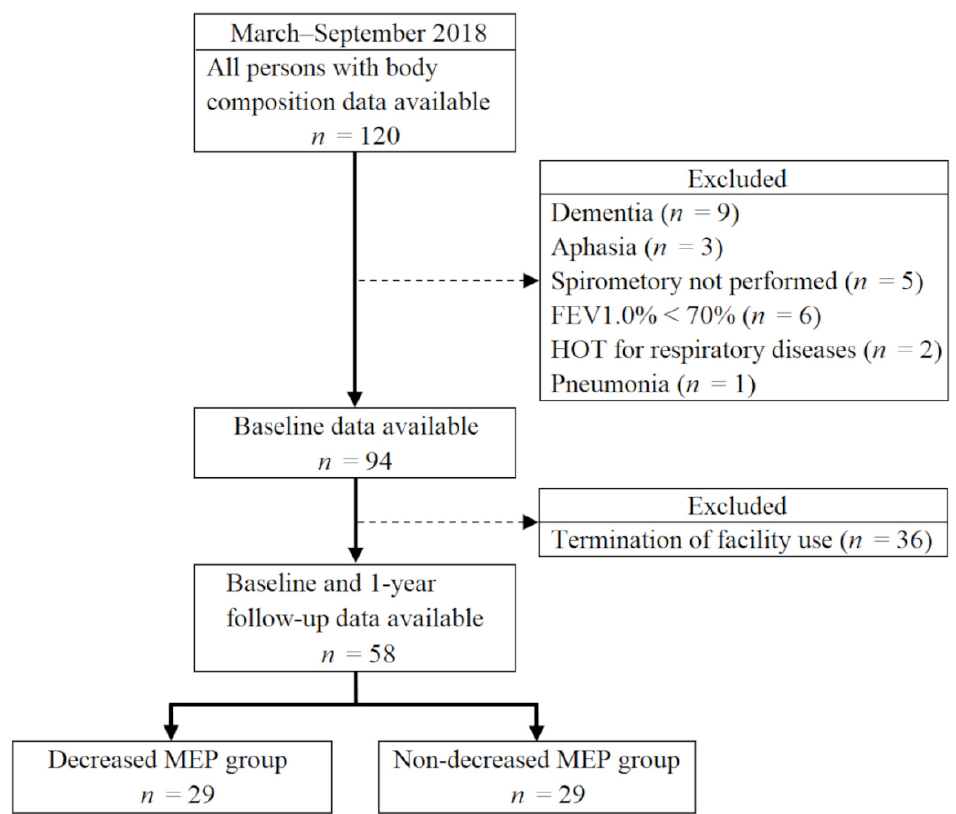
Figure 1. Flowchart of participant selection. FEV1.0%, forced expiratory volume % in one second; HOT; home oxygen therapy; MEP, maximum expiratory pressure.